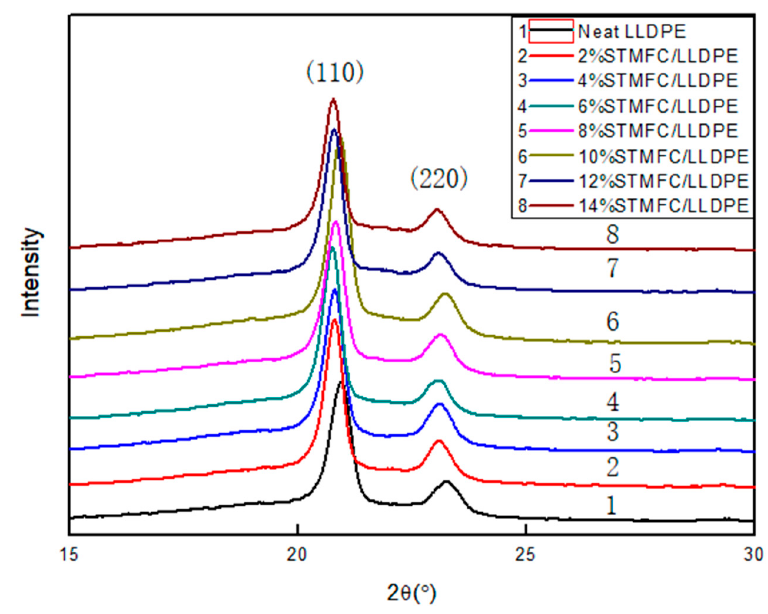
Figure 9. XRD curves of STMFC/LLDPE composite films with different contents.